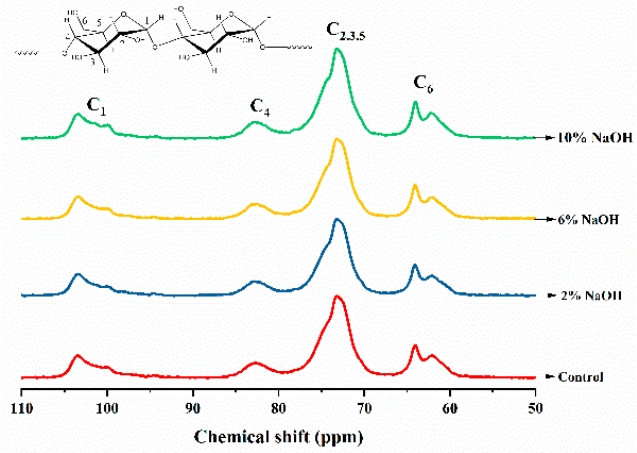
Figure 8. 13 C solid-state NMR spectra of HAS films treated with di ff erent concentrations of NaOH.